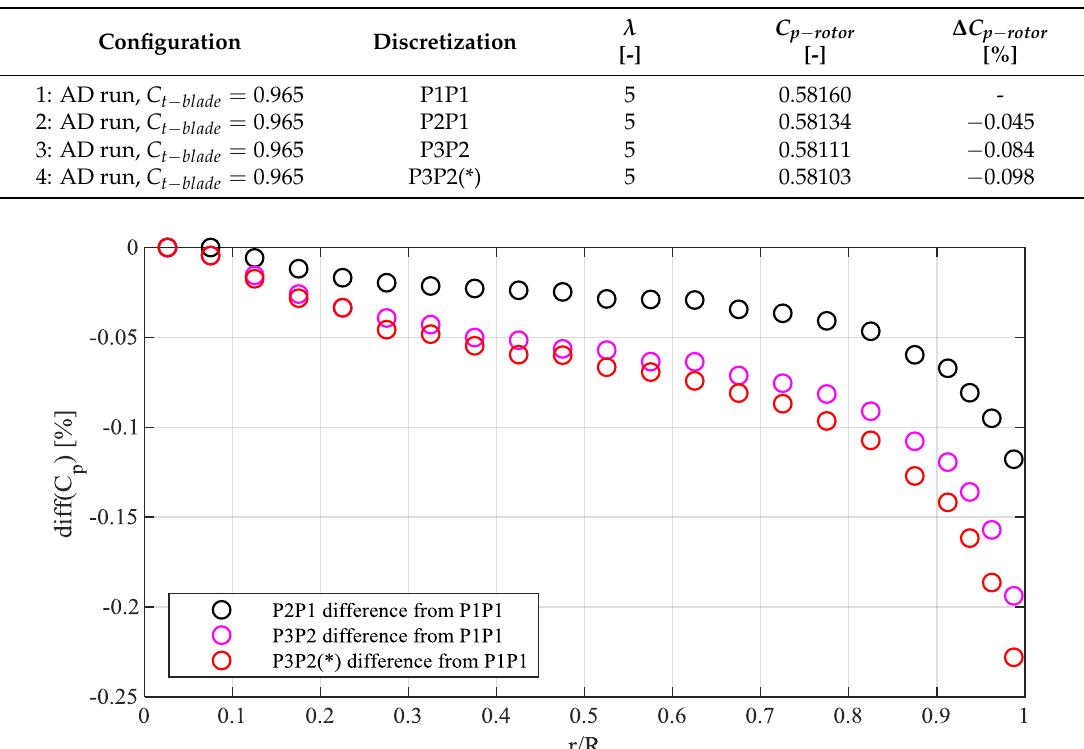
Table A1. Discretization independency test results.